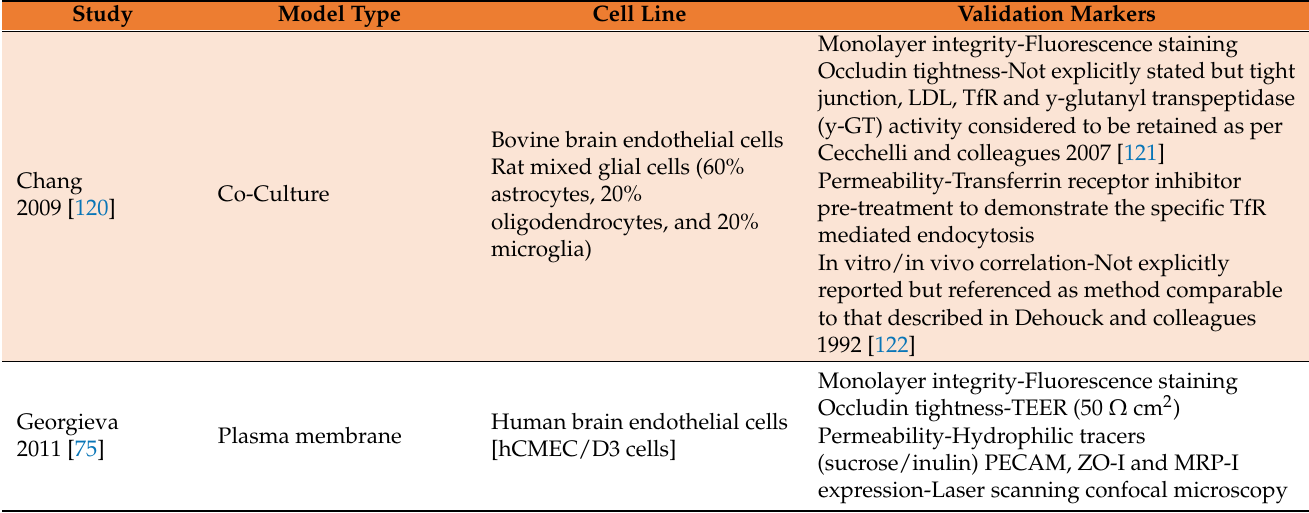
Table 2. Executive summary of included cell-based models and associated validation